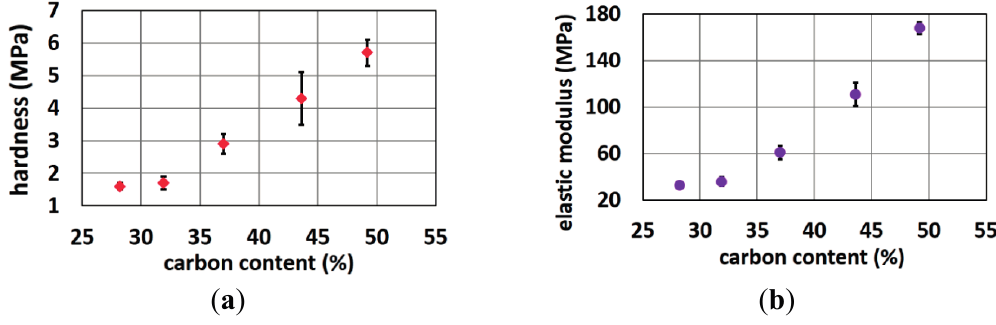
Figure 7. ( a ) Hardness and ( b ) elastic modulus of polymer cylinders with various carbon content.